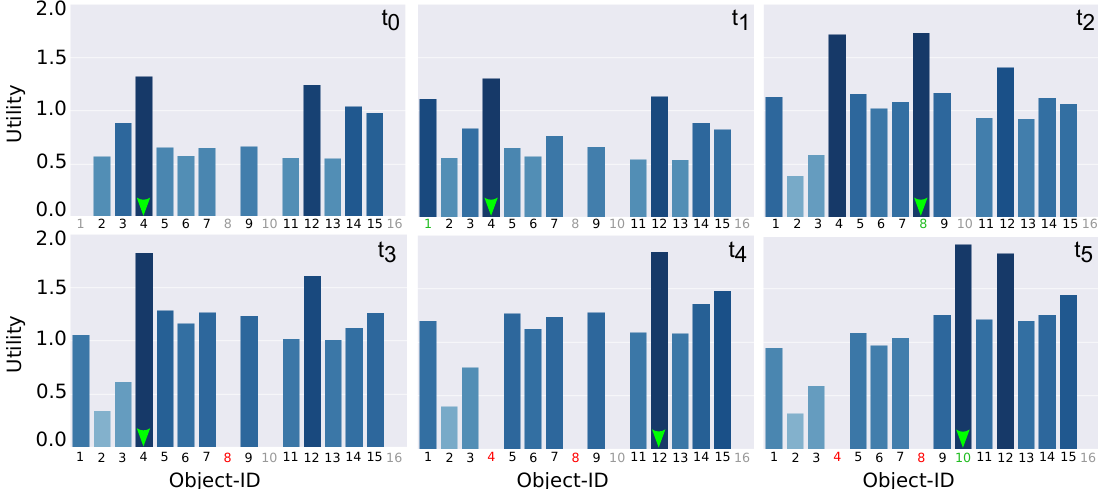
Figure 8. MDP utilities associated to each candidate object at the different time steps. The ID of each object is colored as grey if not yet detected, green when the object has been detected and introduced in the candidates list, and red when the object has been discarded as not being the source. The candidate with the highest utility is marked with a green